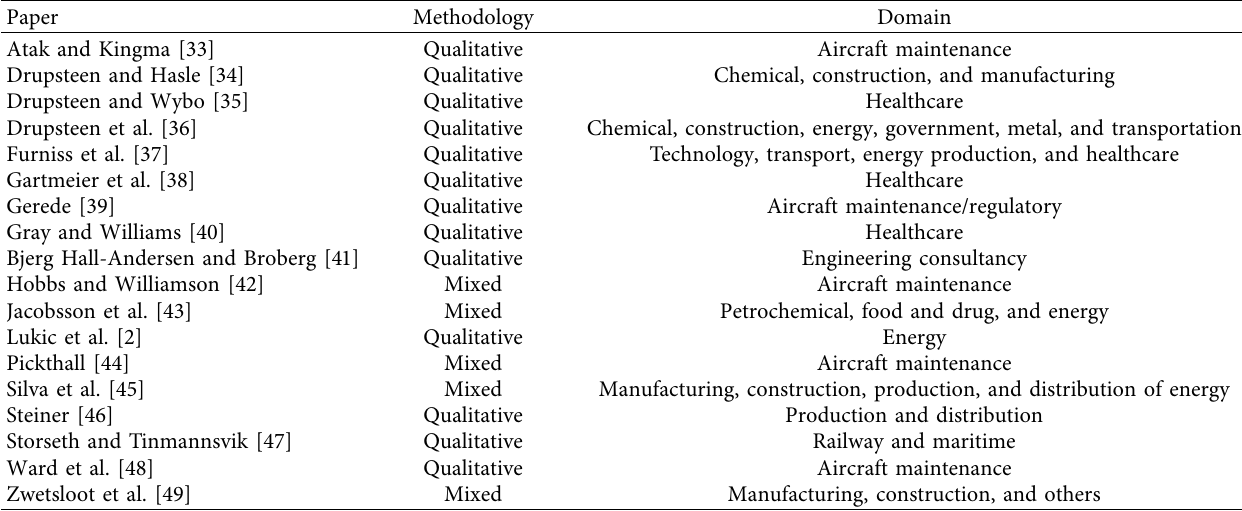
Figure 2: Output of the progressing filtering process applied during the systematic review, leading to the 18 publications (final set of publications). Table 3: A summary of attributes of the papers arising from the systematic literature